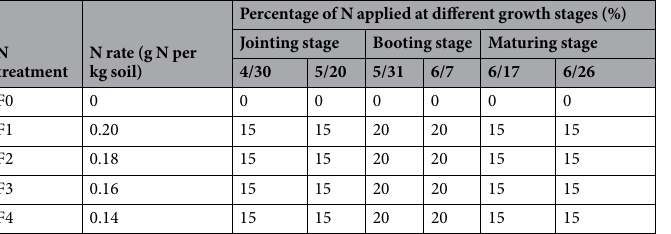
Table 6. N fertilization dates and percentages during the growing season for different N fertigation treatments. 4/30, 5/20, 5/31, 6/7, 6/17 and 6/26 were N supplied